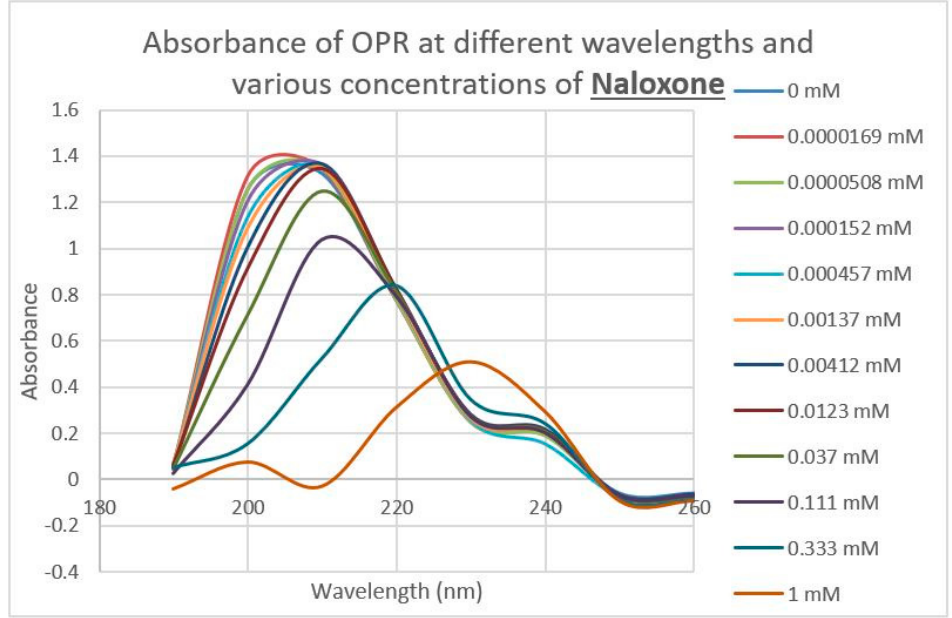
Figure 9. Effect of serial additions of methadone at increasing concentrations on the UV spectrum of intact mu opioid receptors (muOPRs). Compare with Figures 7 and 8.